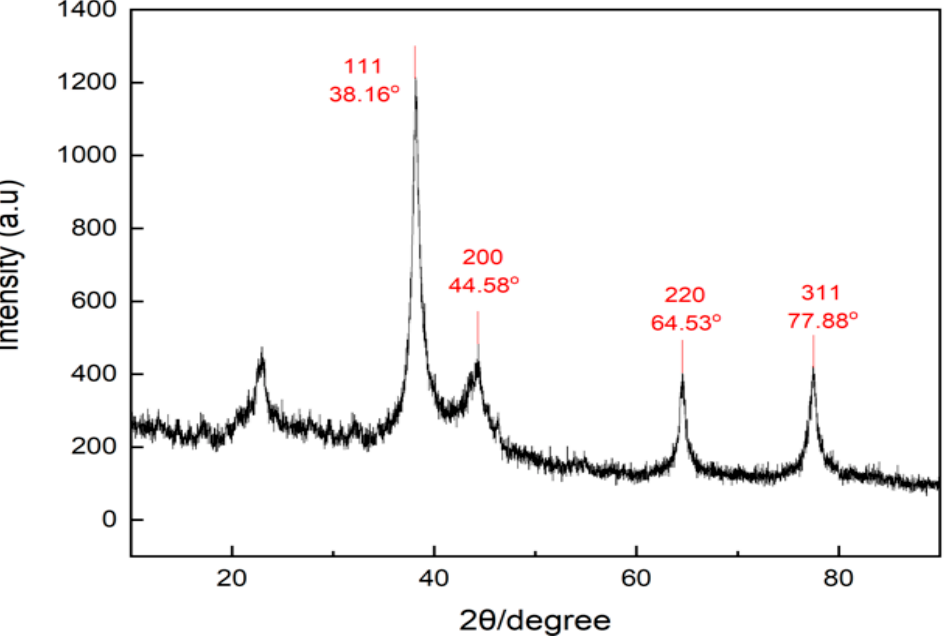
Figure 6. X-ray diffraction pattern of silver nanoparticles synthesized using Kepok banana peel